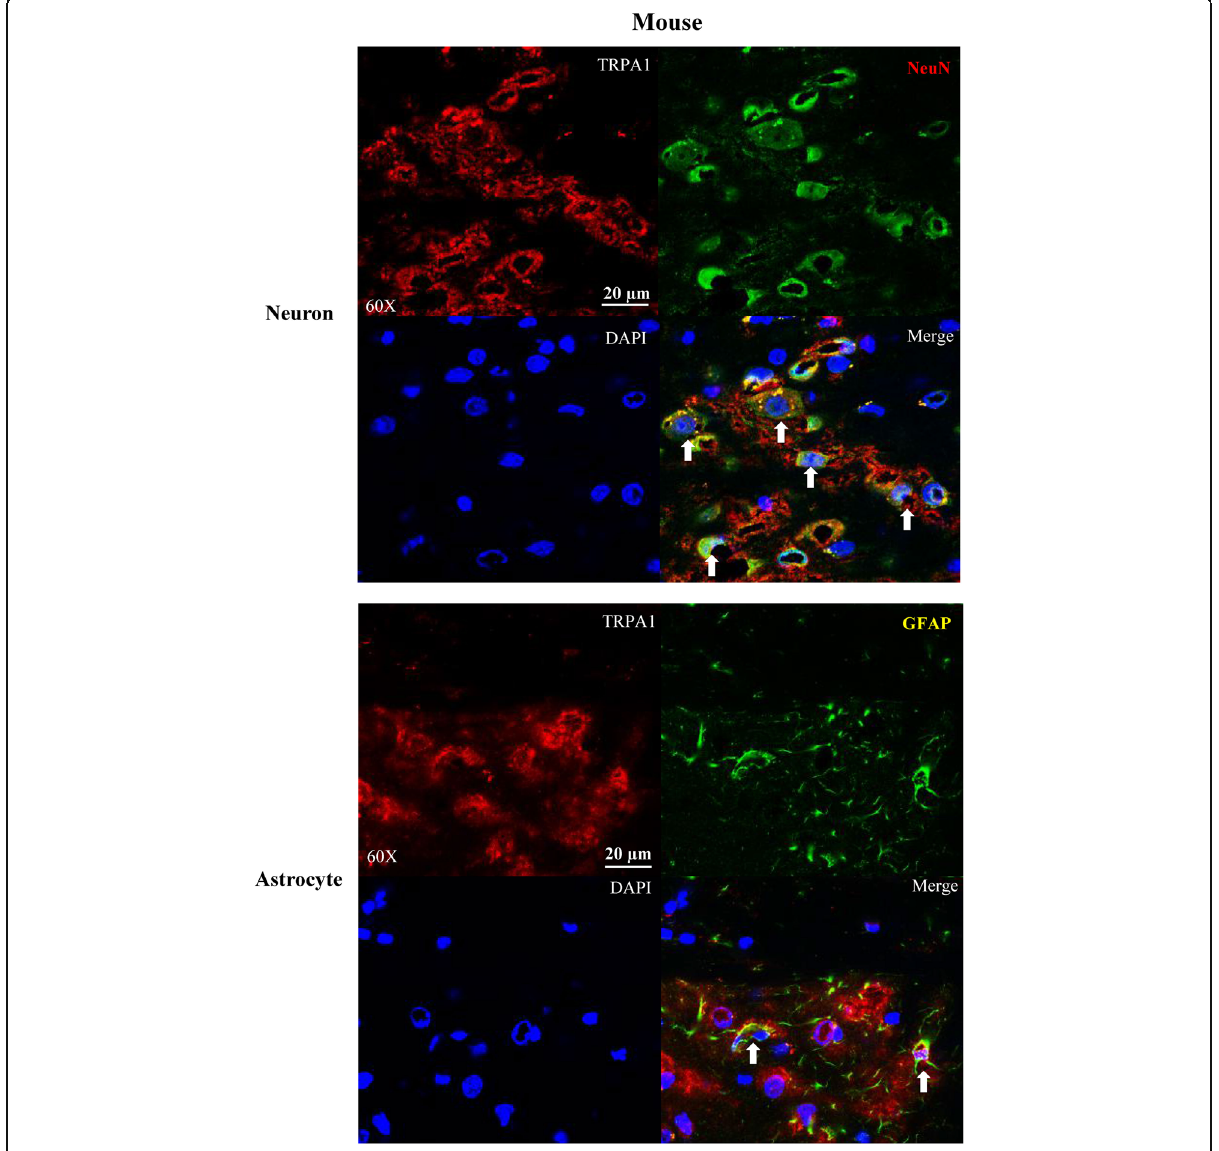
Fig. 2 Representative images showing immunohistochemistry detection of TRPA1 expression in neurons and astrocytes of mouse cerebral cortex. Double immune-labelling showed TRPA1 expressed in cerebral cortical neurons (upper panel, white arrows) and astrocytes (lower panel, white arrows). DAPI staining indicates nucleus is shown in blue; TRPA1 in red, NeuN indicates neurons or GFAP indicates glial cells shown in